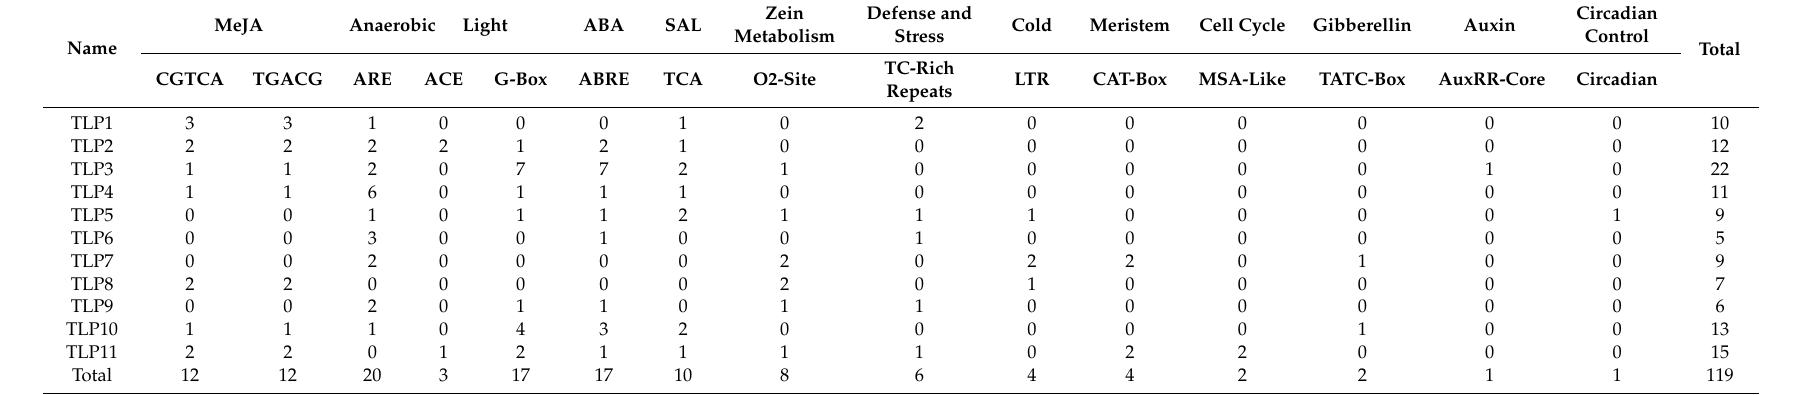
Table 2. Cis-acting regulatory elements in the promoter sequences of tomato TLP